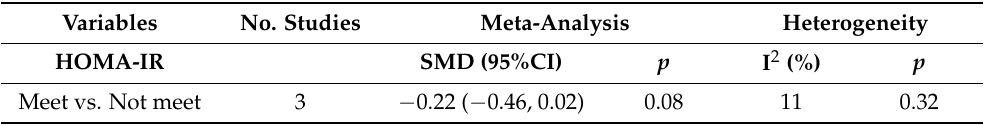
Table 5. The meta-analysis of the effect of meeting physical activity guideline on HOMA-IR (all analyses were performed using the random-effect